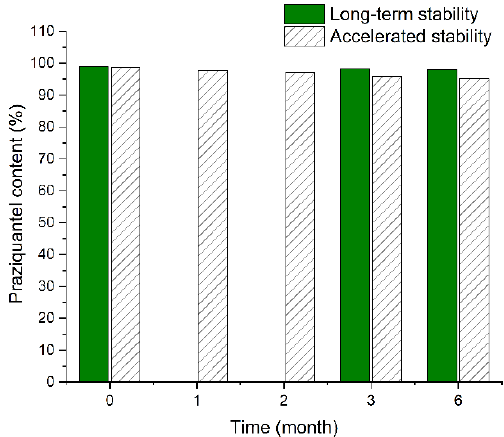
Figure 7. Changes in the chemical content of praziquantel in PZQ ODSRTs under accelerated and long-term conditions.